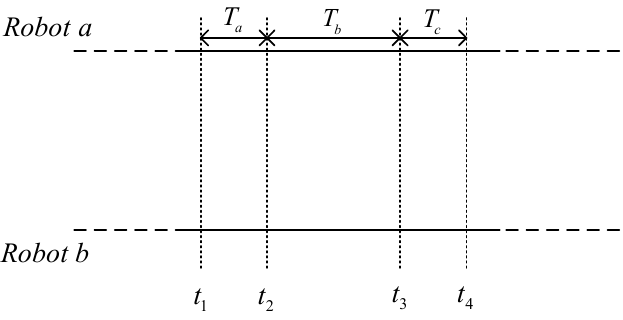
Figure 1. Timeline of the robot-to-robot communication.